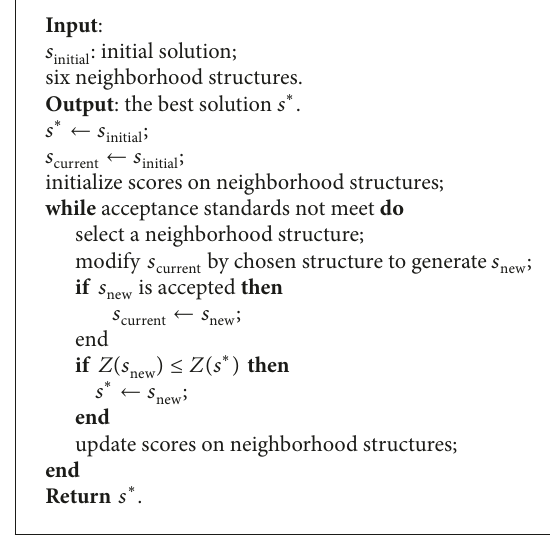
Algorithm 1: Procedure of the